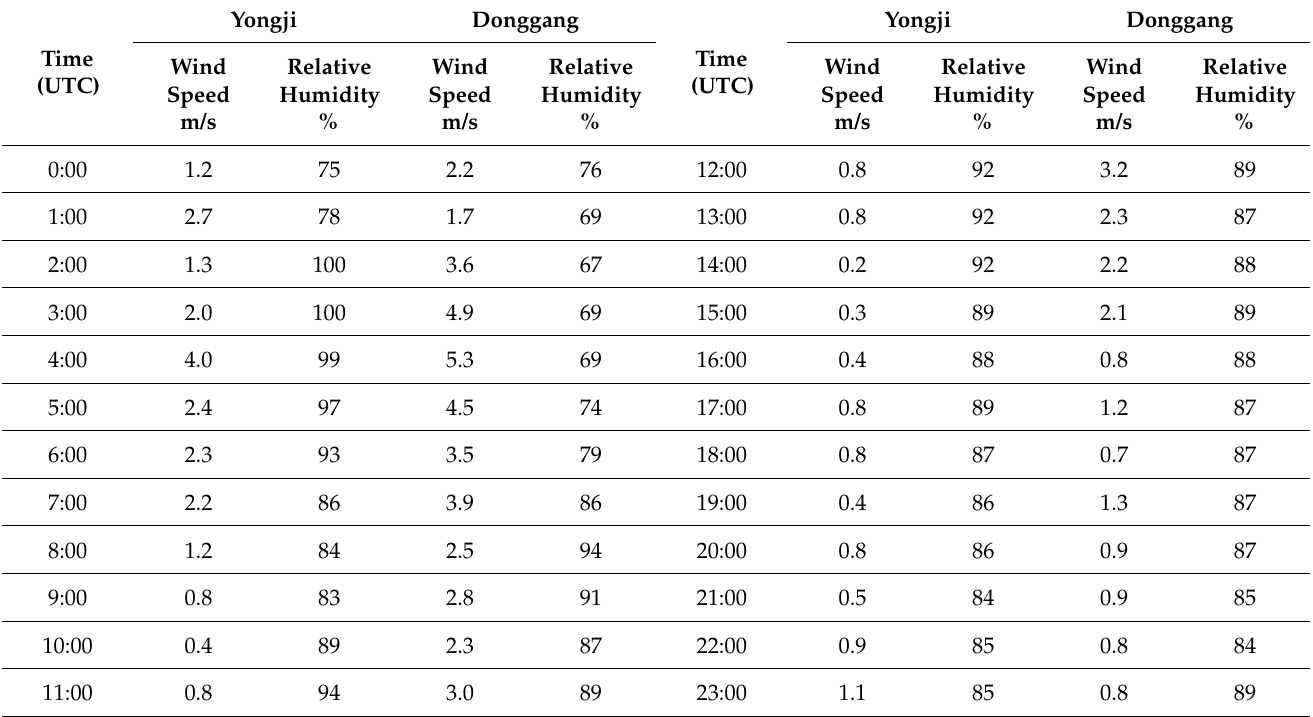
Table 5. Wind speed and relative humidity of Yongji and Donggang stations on 8 January